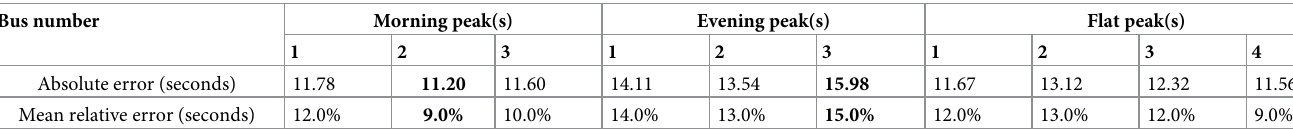
Table 1. Average absolute error and relative error of travel time prediction of the route segment. Bus